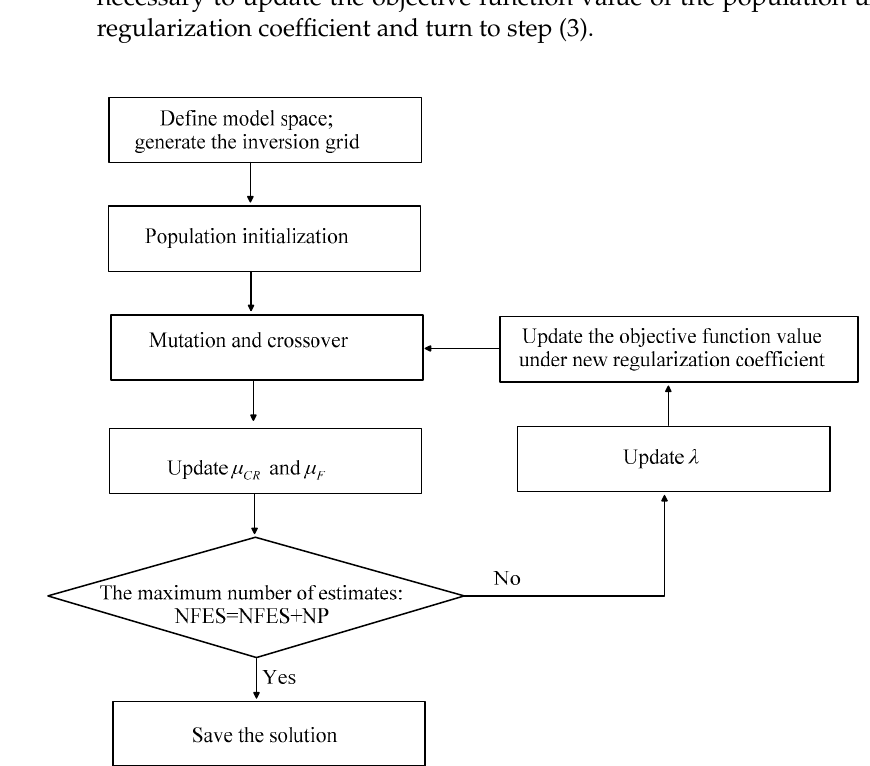
Figure 2. Flowchart of the differential evolution (DE) algorithm for the inversion of magnetic data.